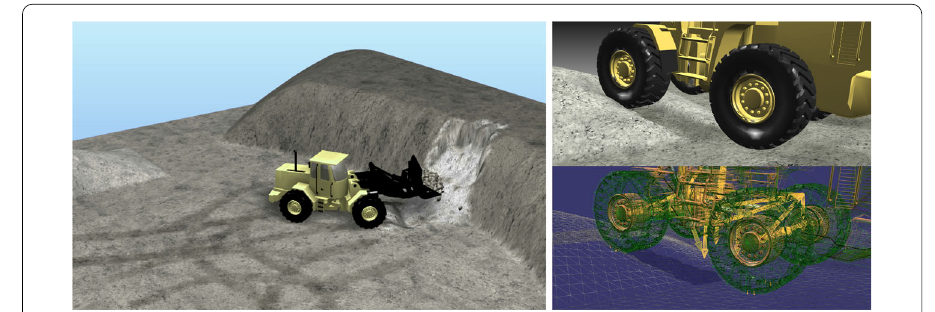
Fig. 22 Demonstration of variable soil compaction and swelling. The subsoil stress from the tires cause compaction (dark grey). Particles that are converted back to resting solid become more loosely packed (light grey) than nominal bank state